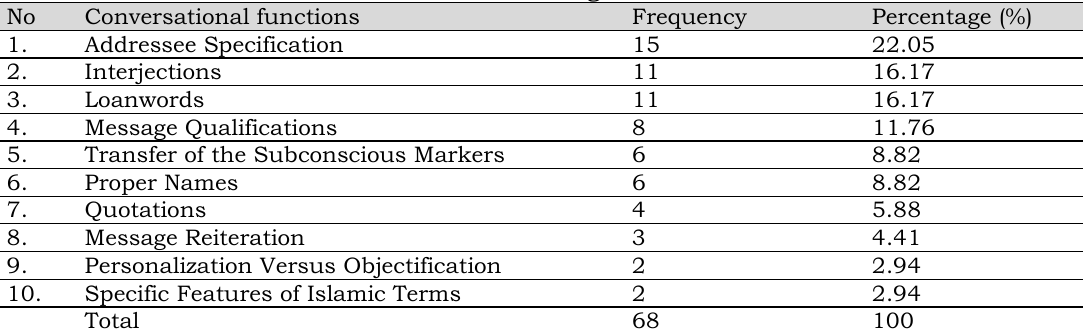
Table 3 : The functions of code switching in thesis defense